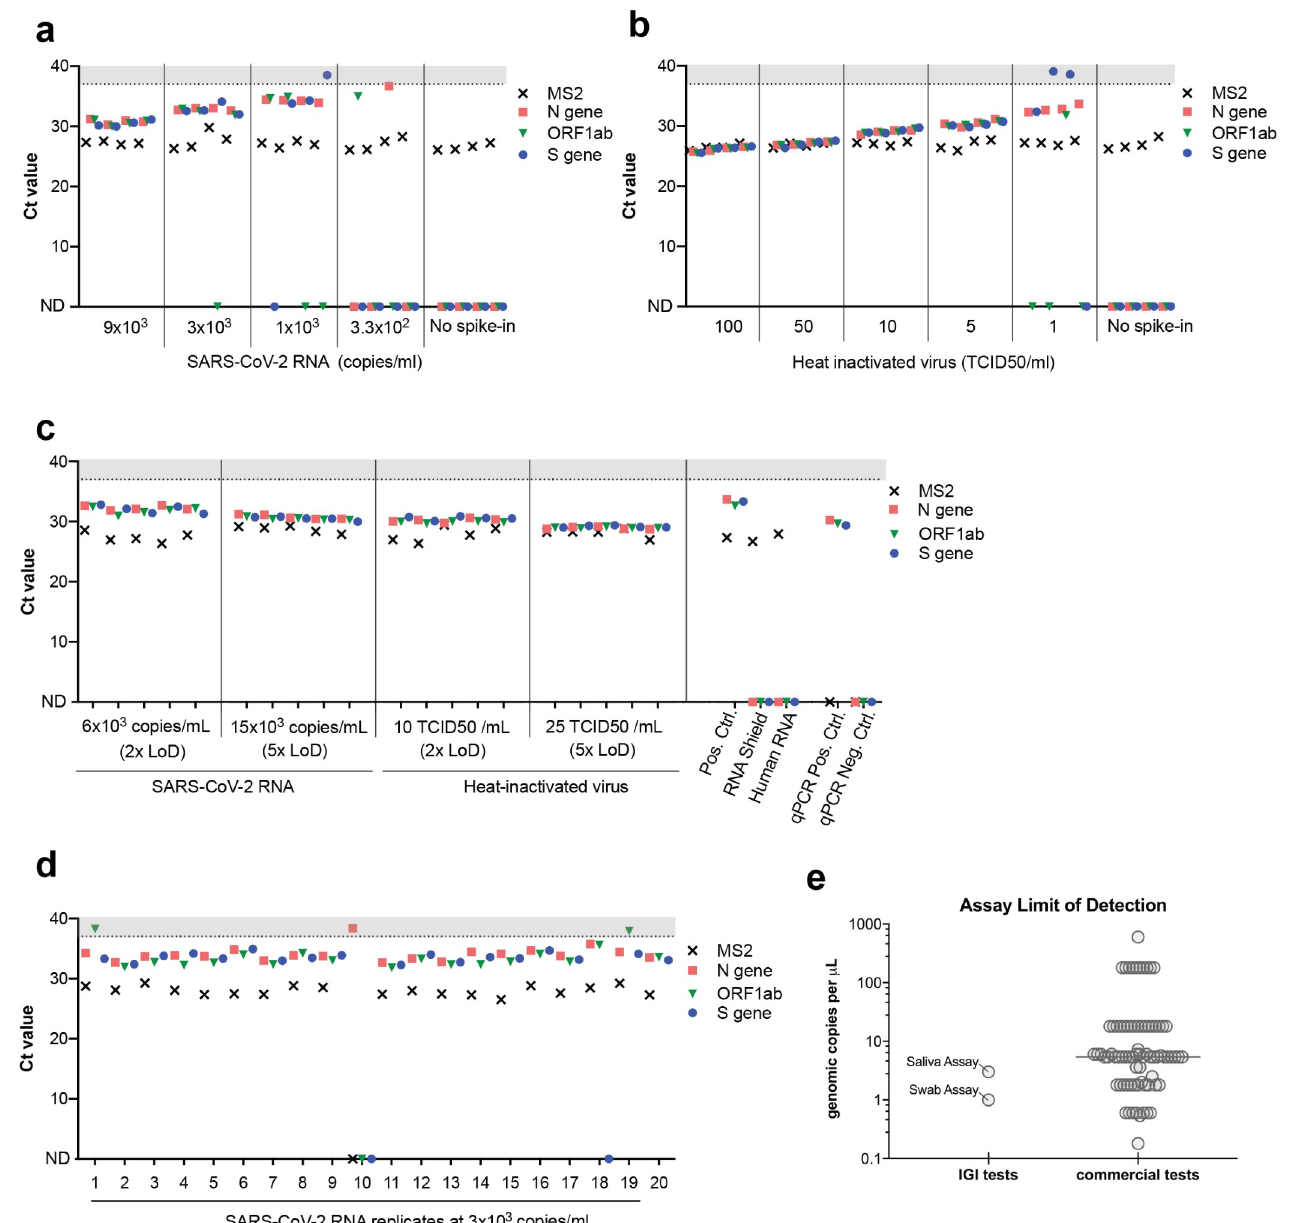
Fig 2. Validation of the IGI’s assay for detecting SARS-CoV-2 RNA from saliva. Saliva collected from four unique donors (negative for SARS-CoV-2 by swab) was used to generate a titration curve of ThermoFisher COVID-19 Positive Control SARS-CoV-2 RNA (a) or heat-inactivated virus (b) to determine the assay’s limit of detection (LoD). c, SARS-CoV-2 RNA or heat-inactivated virus was spiked in at 2x or 5x the LoD into 20 unique saliva samples previously determined to be negative for SARS-CoV-2. d, SARS-CoV-2 RNA was spiked into 20 unique saliva samples previously determined to be negative for SARS-CoV-2 at 1x LoD (3x103 copies/ml). A positive extraction control (Pos. Ctrl) negative extraction controls (DNA/RNA Shield, Human RNA) and qPCR controls all returned expected results (c). Ct values > 37 are shaded in gray. Undetected Ct values are plotted as zero and designated by “ND”, not detected. e, Limit of detection (RNA copies/ μ l) comparison of commercial assays and the IGI saliva and IGI swab tests generated from the FDA website